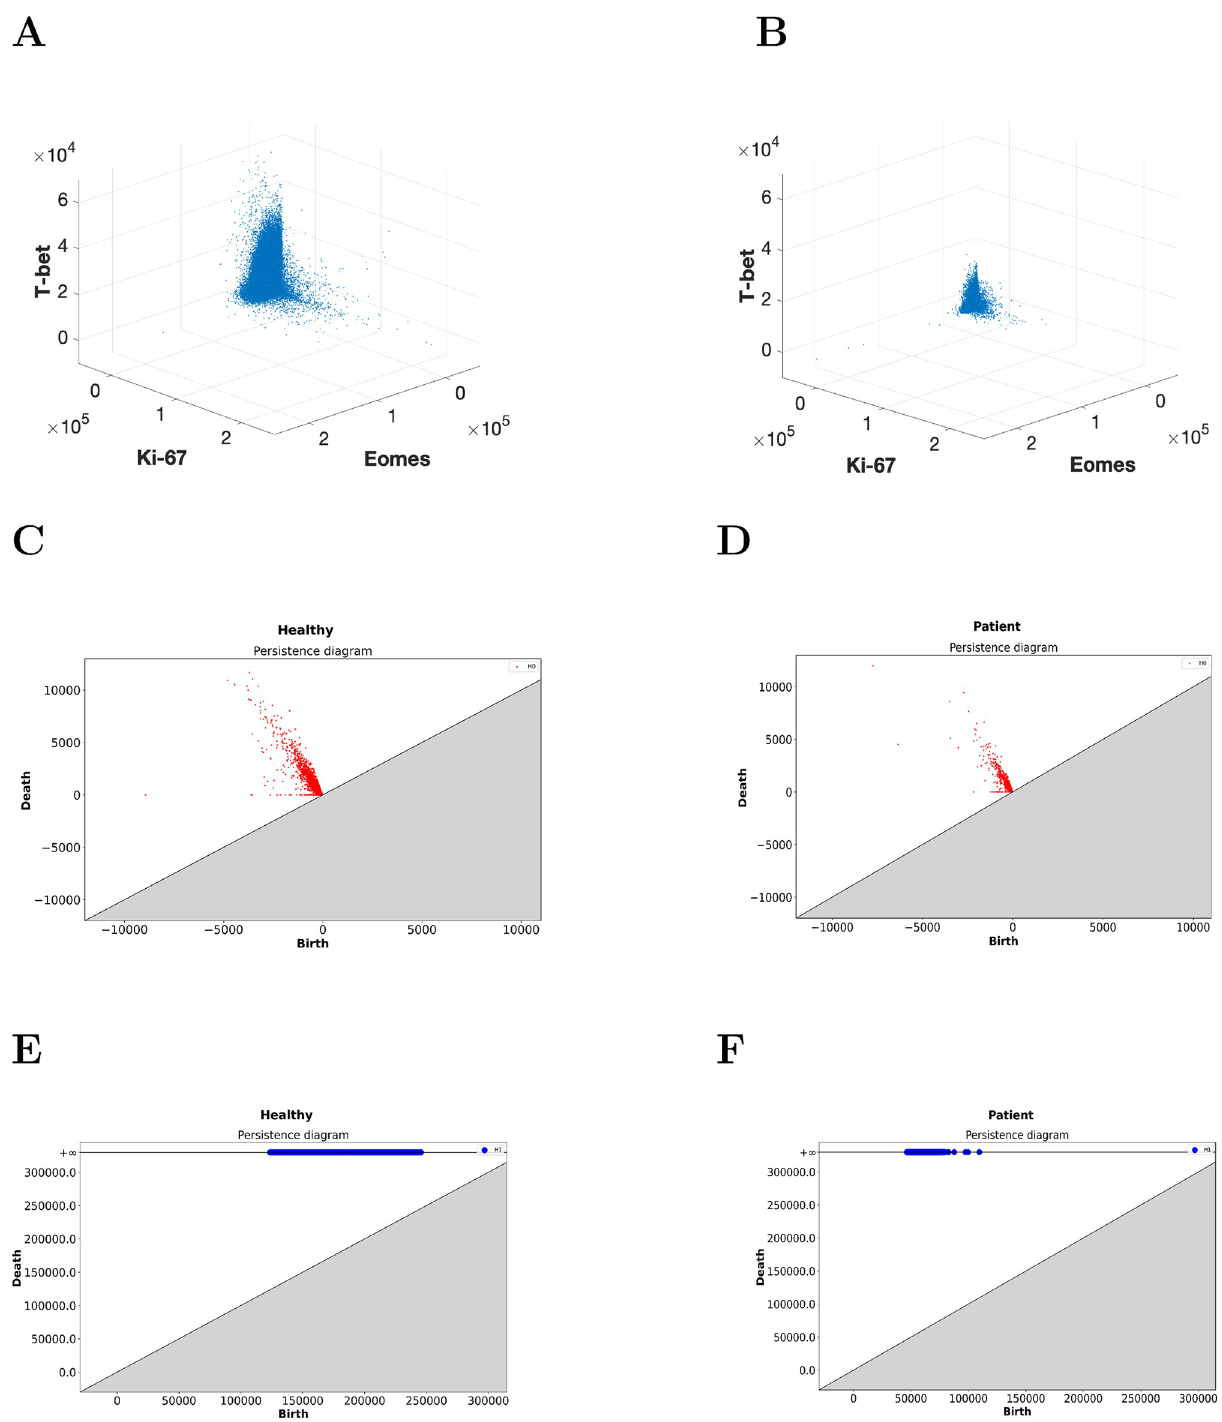
Fig 6. Differences in shape features in the 3D point cloud for CD8+ T cells in a H × P pair. CD8+ T cell point cloud for proteins Eomes, Ki-67, and T- bet for (A) a healthy control and (B) a COVID-19 patient. (C) Shows H 0 -persistence diagram for the healthy control in (A). (D) Shows the H 0 -persistence diagram for the COVID-19 patient in (B). (E) H 1 -persistence diagram for the healthy control in (A). (F) H 1 -persistence diagram for the COVID-19 patient in (B).